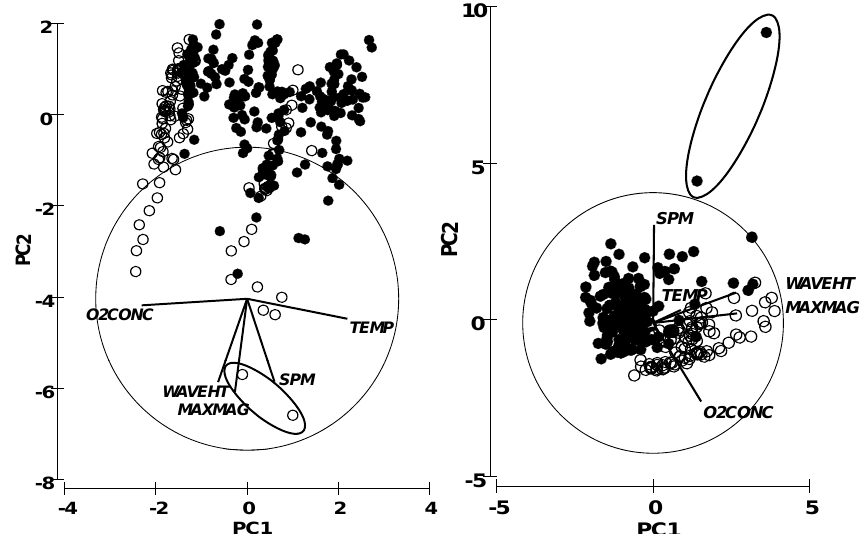
Fig. 7. Principal component analysis for (a) Oyster Grounds and (b) North Dogger. Open circles denote samples under mixed condi- tion, closed circles represent samples under stratified conditions. O2CONC is oxygen concentration (mgl − 1 ) ; TEMP is temperature ( ◦ C); WAVEHT is wave height (m); MAXMAG is maximum daily average current speed (ms − 1 ) ; SPM is suspended particulate matter (mgl − 1 )